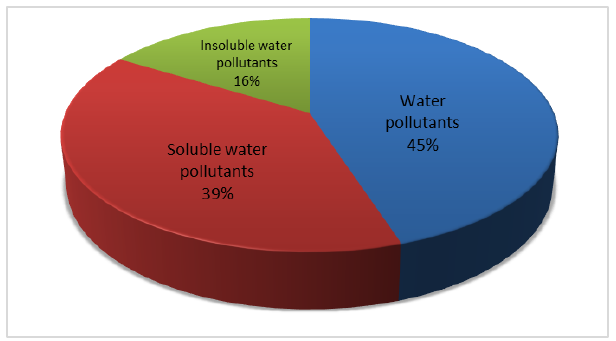
Fig. 9. Percentage of water pollutants at E